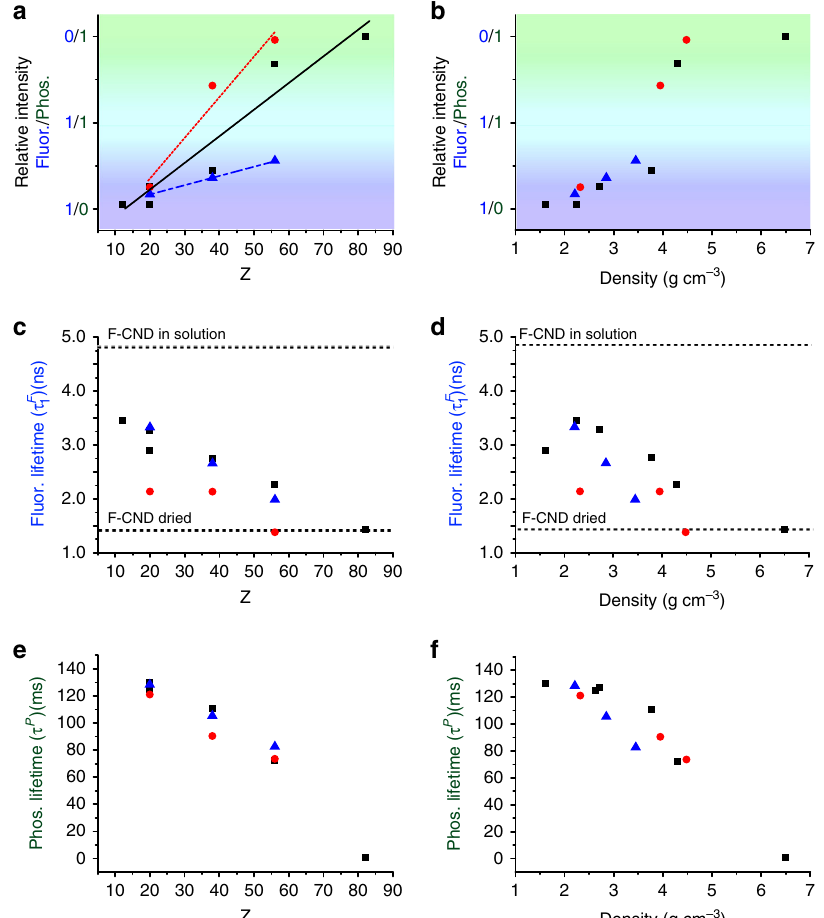
Fig. 3 The relationship between host structure and photoluminescent (PL) behaviour in folic acid-derived carbon nanodot (FF-CND)/host nanocomposites. Plots of relative room temperature phosphorescence (RTP) intensity values ( a , b ), fl uorescence ( τ F ) lifetimes derived from fl uorescence lifetime imaging 1 microscopy (FLIM) decay curves ( c , d ) and phosphorescence ( τ P ) lifetimes derived from video stroboscopy decay curves ( e , f ) of F-CND-rich carbonates (black square/solid line), sulphates (red circle/dotted line), and oxalates (blue triangle/dashed line) against cation Z ( a , c , e ) and density ( b , d , f ) of the host mineral phase. The background colour in a and b represents approximately the steady-state PL (SS-PL) observed from photographs obtained from composites under UV (365 nm) excitation. Values for τ F for F-CND aqueous solution and dried F-CND are given on c and 1